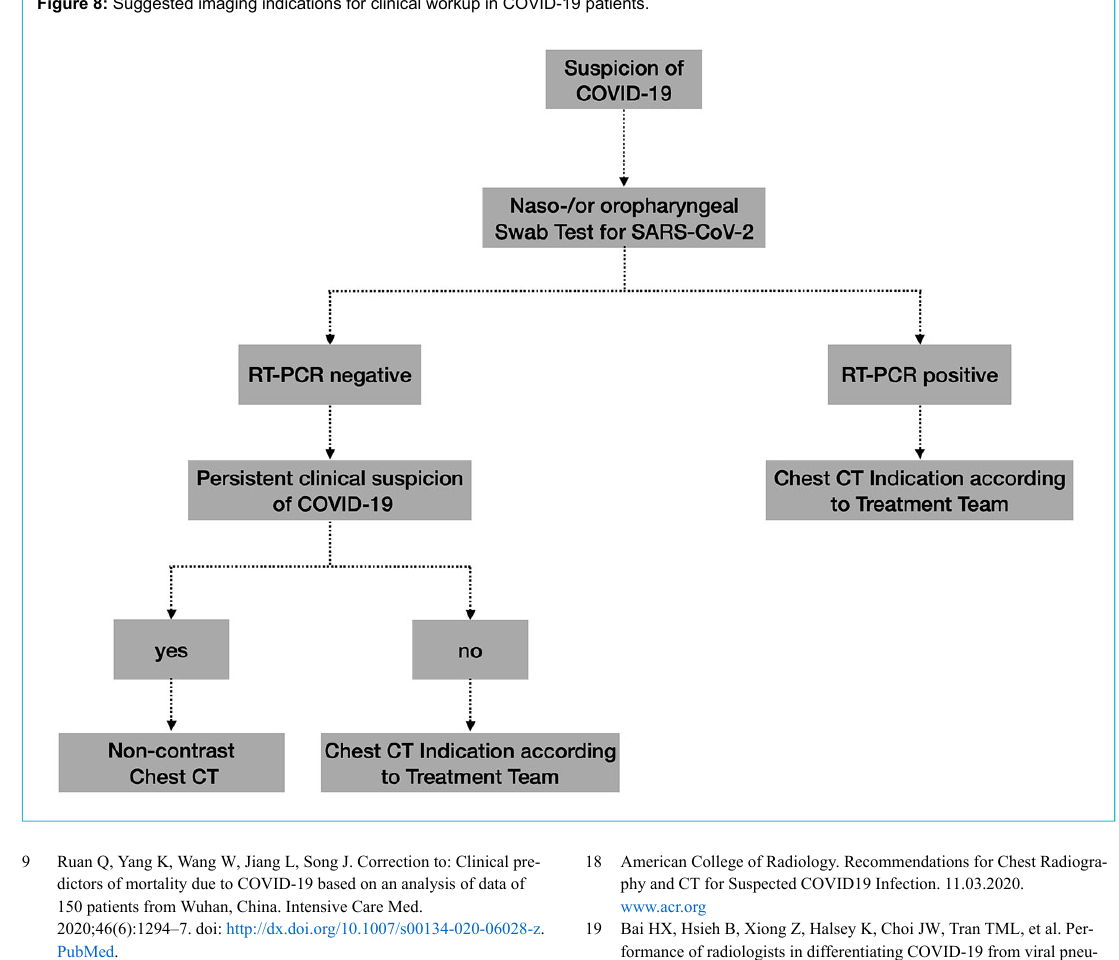
Figure 8: Suggested imaging indications for clinical workup in COVID-19